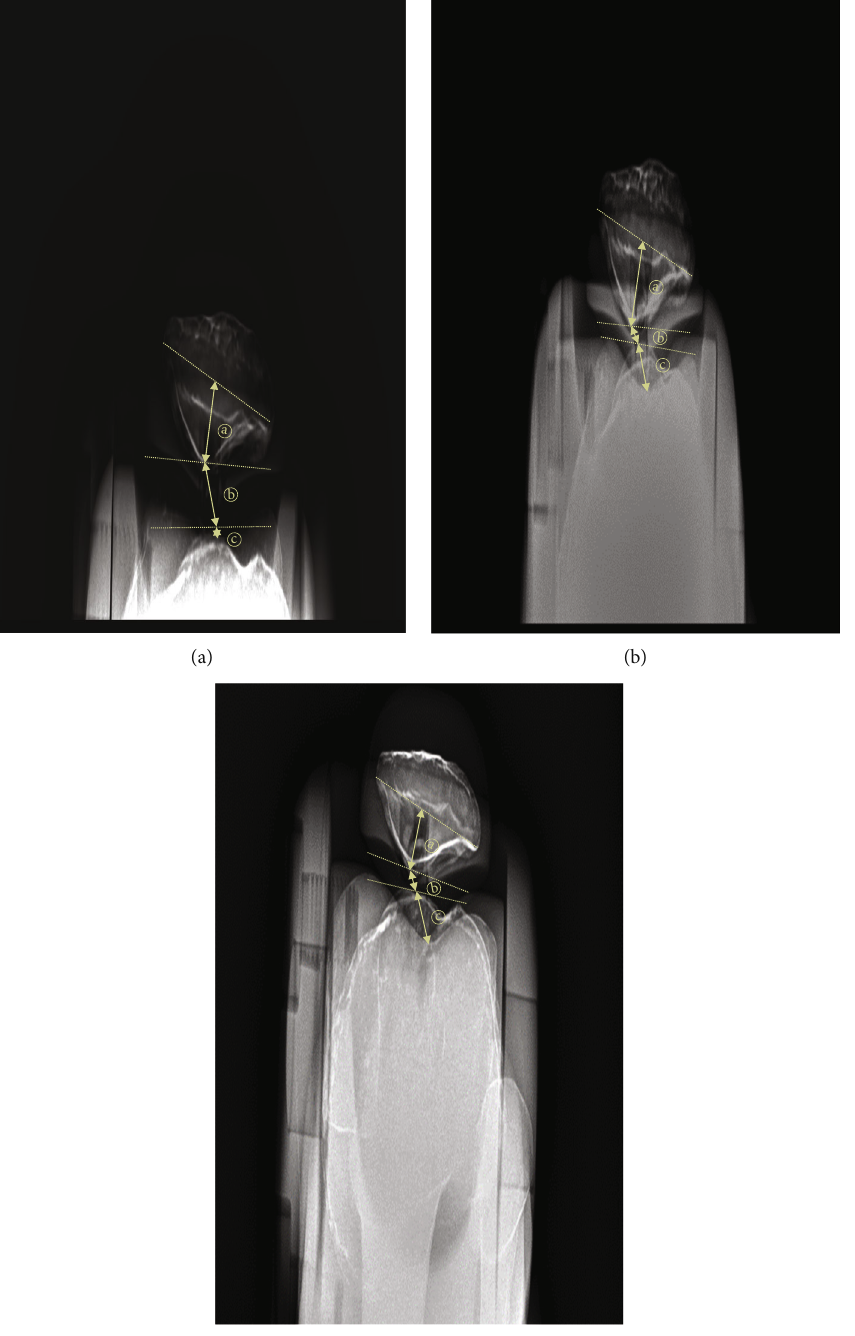
Figure 8: Phantom X-ray images taken by each method ((a) DMLP, (b) DPFG, and (c) DFGT). (a) Method using PJR. (b) Merchant method. (c) Settegast